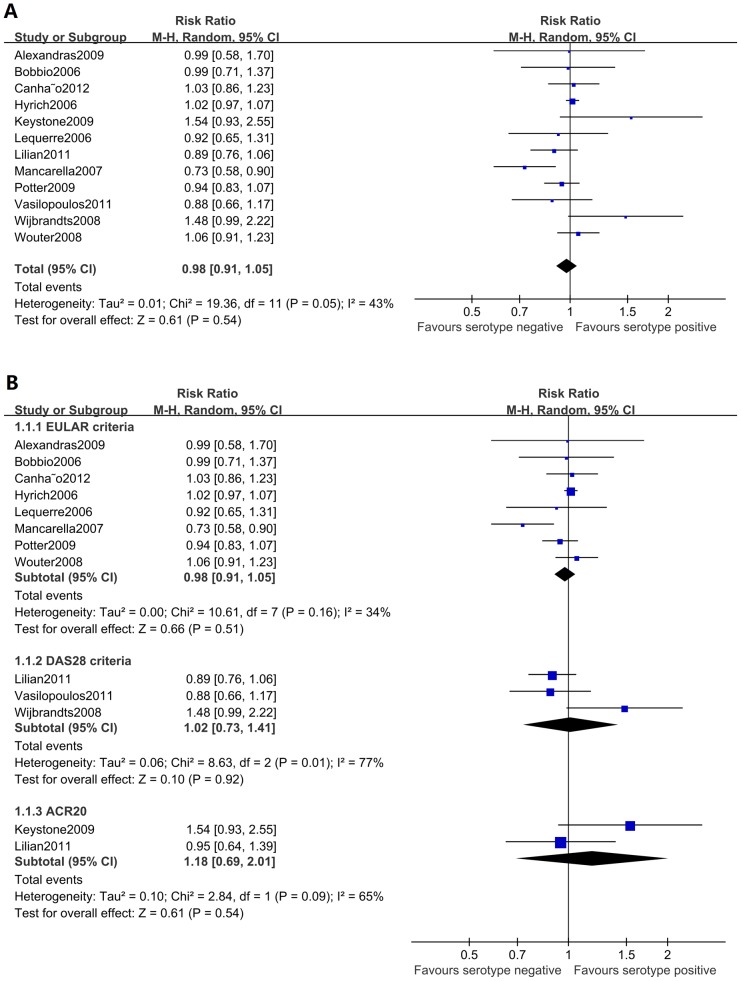
Forest graphs of the meta-analysis of RF status and response to anti-TNFα agents.The overall analysis of RF status showed a pooled RR of 0.98 (95% CI: 0.91–1.05, p = 0.54) and an I2 of 43%. Subgroup analyses on different response criteria revealed no significant differences.